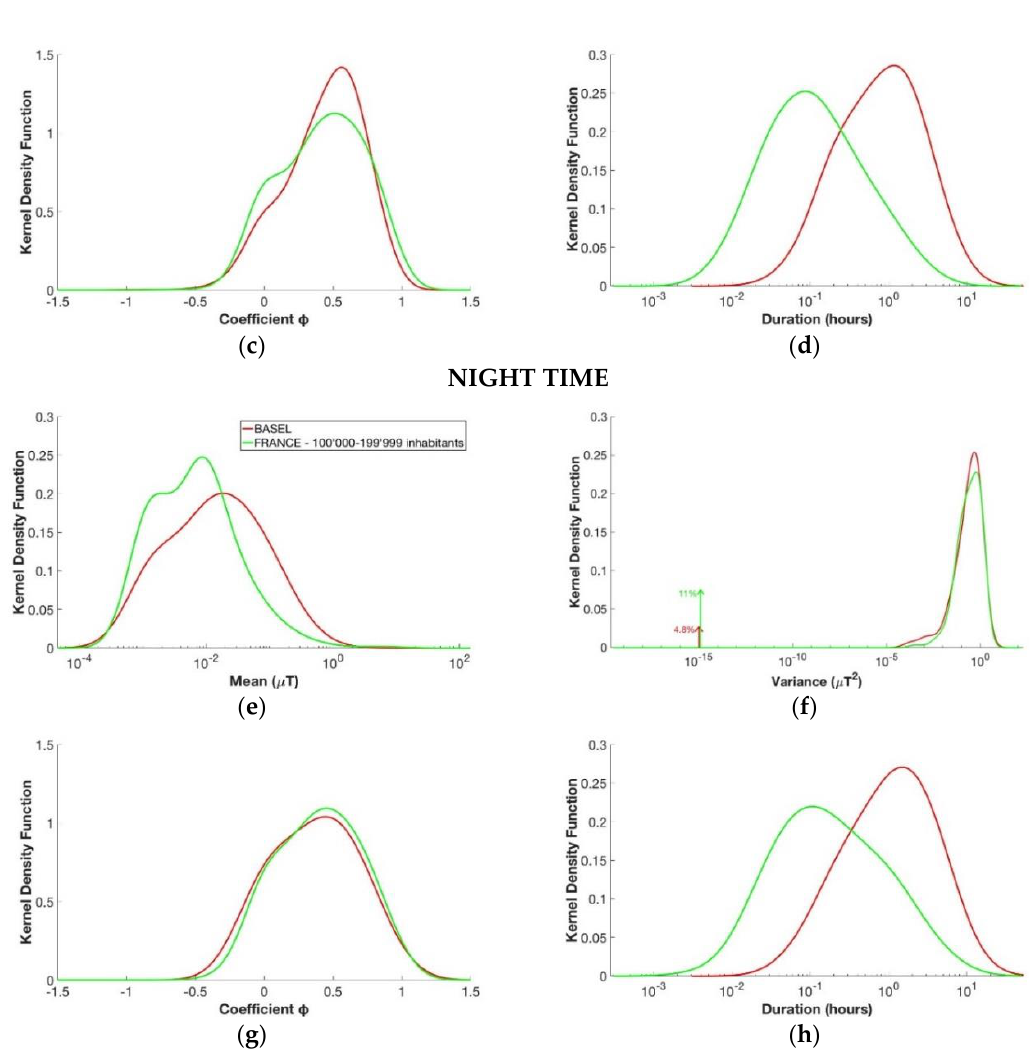
Figure 7. Estimated kernel density function for the four variables of the segments of the day in the upper part and for the segments of the night in the lower part. From above to down, left to right: ( a, e ) mean µ, ( b, f ) variance σ 2 , ( c, g ) coefficient φ, and ( d, h ) duration T. The groups considered are the those with registration of Basel from the ARIMMORA database (in red) and the group of 100,000–19,999 inhabitants from the EXPERS database (in green).